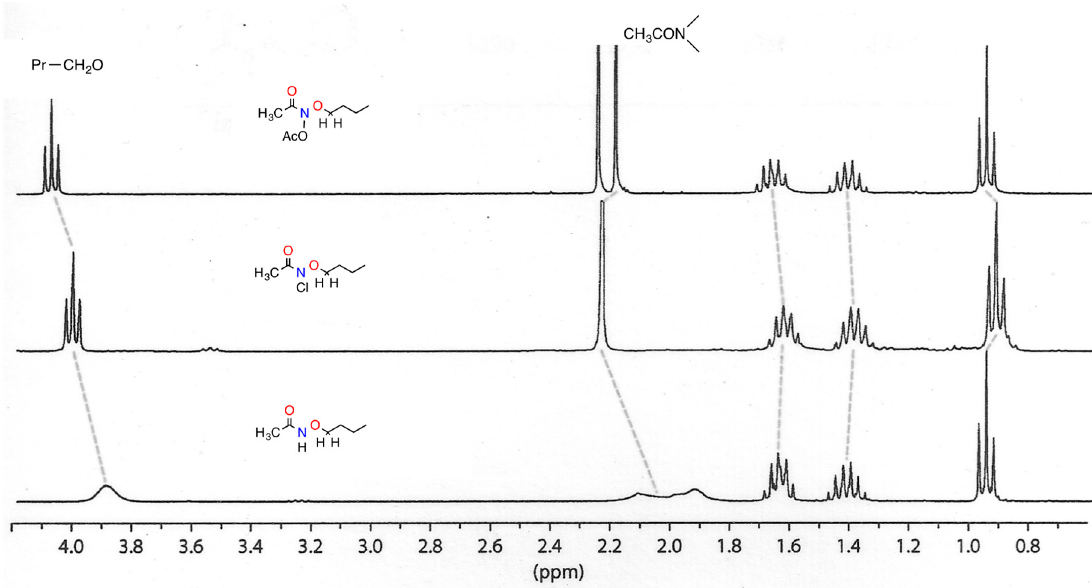
Figure 11. 300 MHz 1 H NMR spectra (300K, CDCl 3 ) of N -butoxyacetamide, and anomeric amides N -butoxy- N -chloroacetamide and N -acetoxy- N -butoxyacetamide.